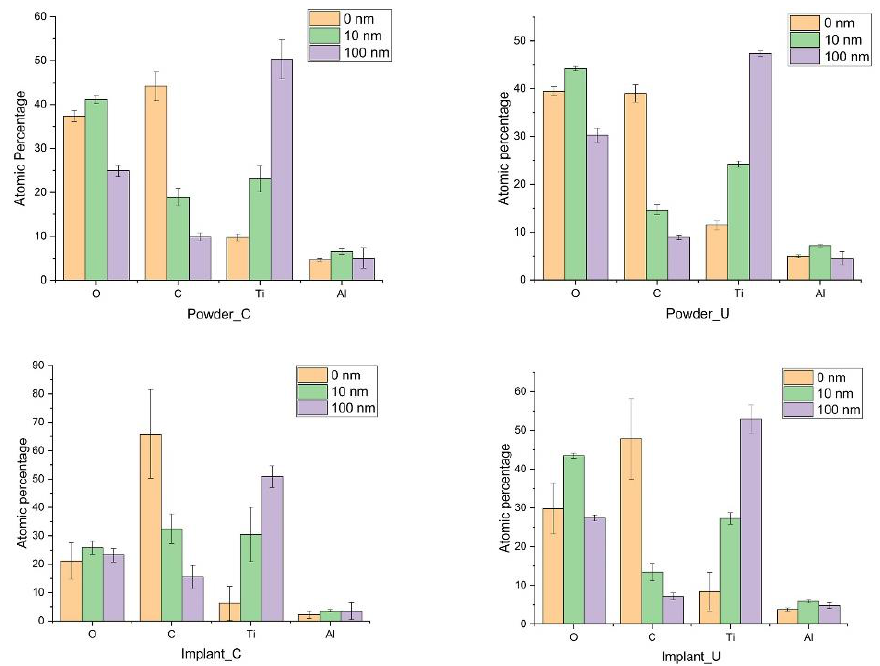
Figure 1. The atomic percentage of the major elements of the samples at three probed depths. The amount of O in the three depths was almost the same between the control powder and the used powder but different from the implant samples. The powder oxidization result is consistent with the study by Cao et al. on recycled powders [35]. For example, at the Implant_C surface (0 nm), a small percentage of the O 1s peak was detected compared to Implant_U, 21.1 ± 6.4% and 29.8 ± 6.5%, respectively. However, at 10 nm depth, a significant difference in the oxygen concentration between Implant_C (25.8 ± 2.4%) and Implant_U (43.5 ± 0.6%) was observed (Figure 1). Higher oxygen content in the